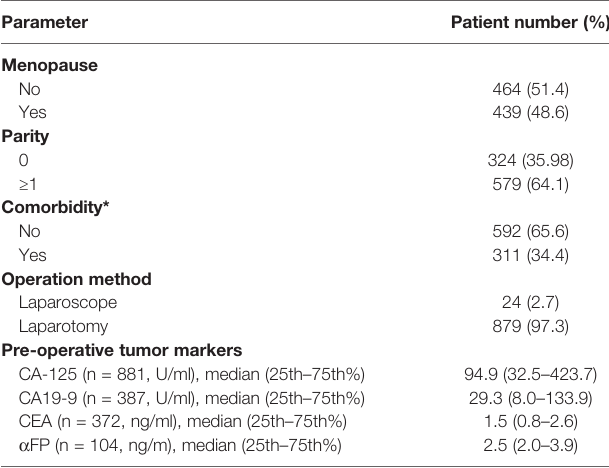
TABLE 1 | Basic characteristics of the 903 women with ovarian tumors that underwent frozen